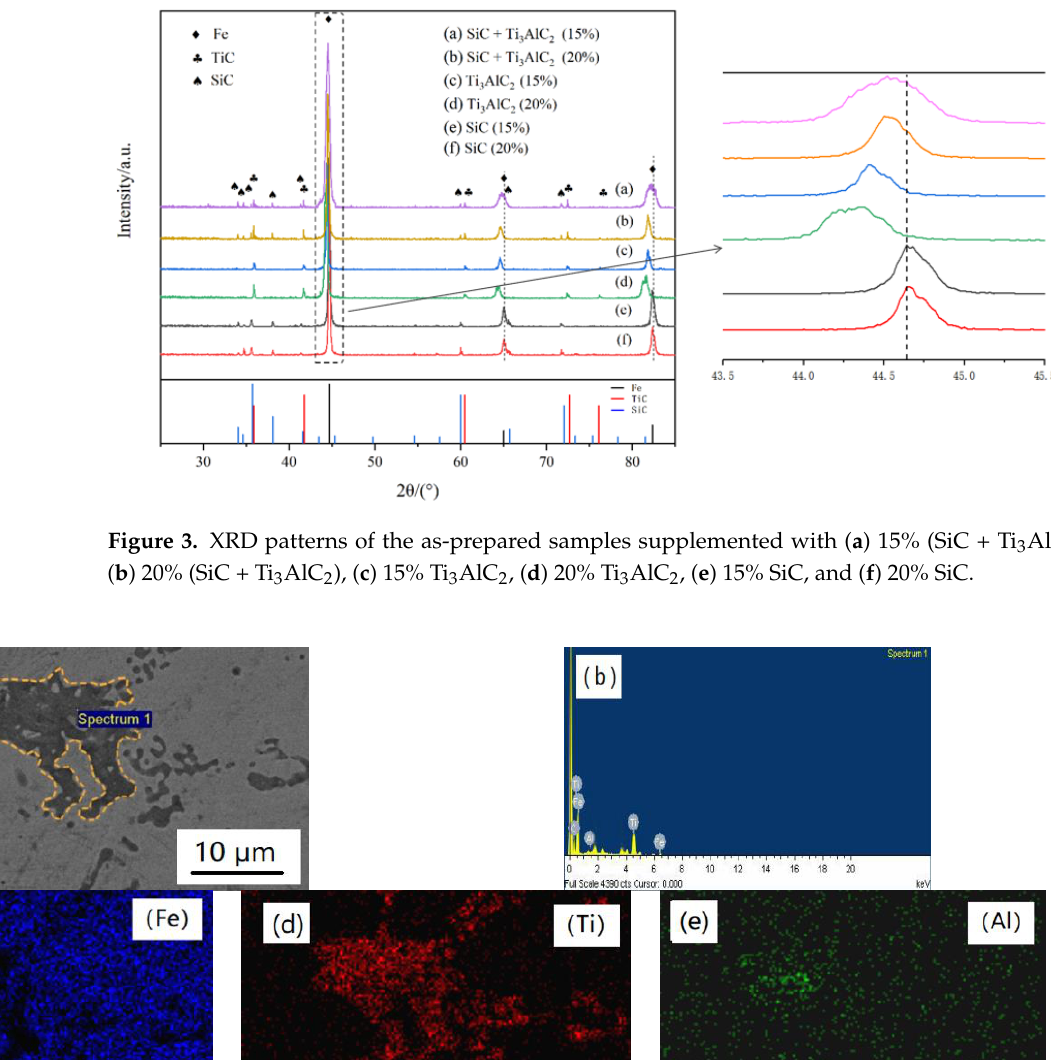
Figure 3. XRD patterns of the as-prepared samples supplemented with ( a ) 15% (SiC + Ti 3 AlC 2 ), ( b ) 20% (SiC + Ti 3 AlC 2 ), ( c ) 15% Ti 3 AlC 2 , ( d ) 20% Ti 3 AlC 2 , ( e ) 15% SiC, and ( f ) 20% SiC.